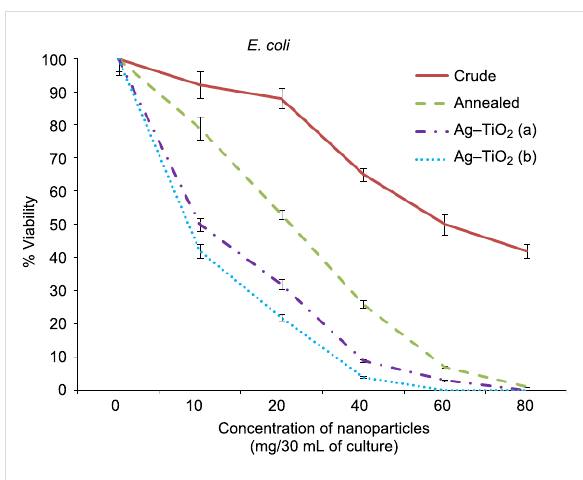
Figure 8: Viability of bacteria ( E.coli ) against the concentration of nanoparticles (mg/30 mL of culture) in %.